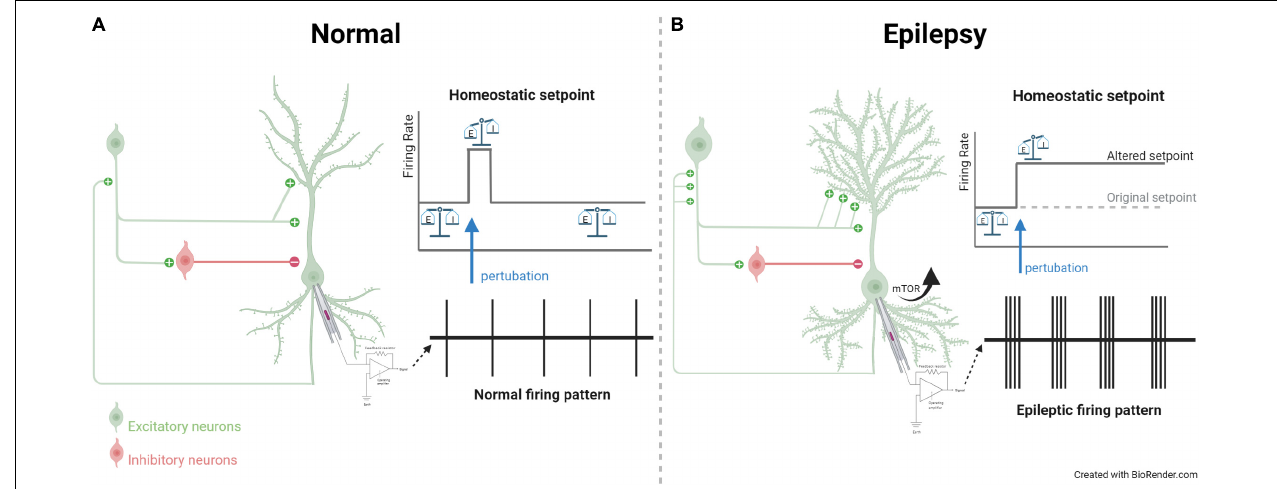
FIGURE 1 | Hypothetical working model contrasting a microcircuit in normal and epileptic brain. (A) In normal condition, excitatory and inhibitory inputs synapsing onto a neuron with a balanced E/I ratio and firing pattern. Upon perturbation, homeostatic setpoint resets the electrical activity back to baseline. (B) In epilepsy, channelopathy or mTOR signaling mutations can lead to changes in intrinsic excitability and synaptic strength of inputs. These changes lead to E/I imbalance and result in characteristic epileptic electrical activity, as indicated by the firing pattern recorded from extracellular recording. Alterations in mTOR pathway also result in morphological changes, including enlarged soma and increased sprouting, further aggravating an imbalanced neuronal circuit. During such a perturbation, the homeostatic setpoint is altered in epilepsy and the electrical activity is unable to return to the baseline setpoint. The figure is created with Biorender with